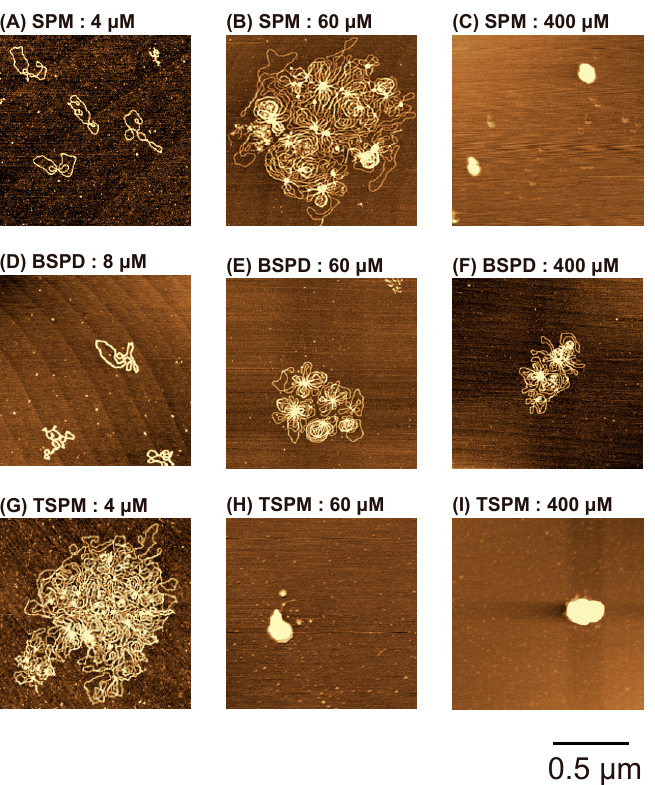
Figure 5. Atomic force microscopy (AFM) images of plasmid DNA (4331 bp) in the presence of various concentrations of ( A–C ) SPM, ( D–F ) BSPD and ( G–I ) TSPM. All specimens were gently adsorbed on a flattened mica surface without shear stress and then dried. The DNA concentration was set at 0.3 µ M in nucleotide